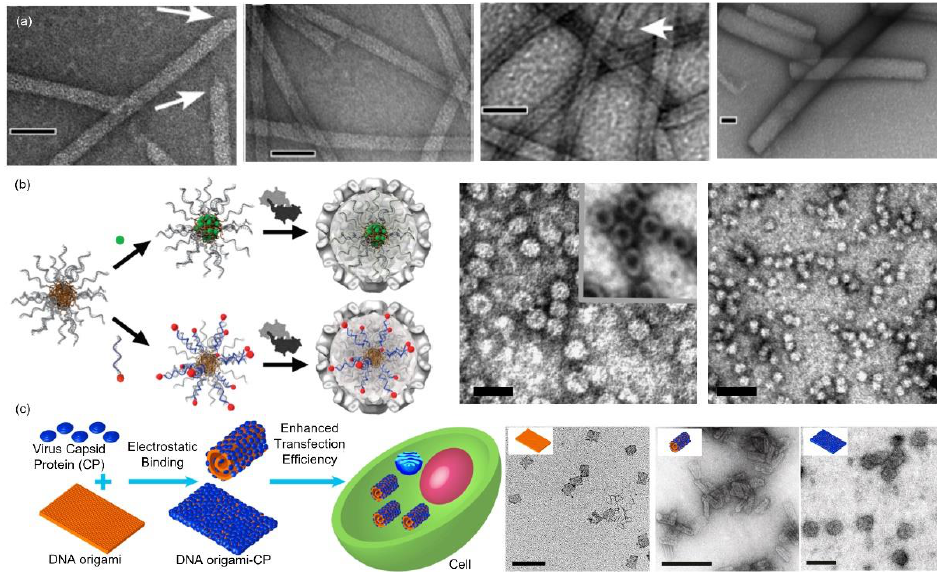
Figure 3. CCMV VLPs templated by DNA nanostructures. ( a ) Representative TEM images of CCMV capsids templated by a 500 bp dsDNA with bp:CP dimer ratios of (from left to right): 1:1, 7:1, 14:1 and 28:1. White arrows mark the hemispherical caps. Scale bar: 50 nm. Reprinted with permission from [48]. Copyright (2006) American Chemical Society. ( b ) Left panel: Schematic illustration of CCMV capsid assemblies templated by DNA micelles and the proposed approaches for drug loading. Right panel: Representative TEM images of (left) assembled CCMV VLPs and (right) free DNA micelles. Scale bar: 40 nm. Reprinted with permission from [50]. Copyright (2010) American Chemical Society. ( c ) Left panel: Schematic illustration of CCMV CP coated DNA origami and the subsequent cellular delivery. Right panel: TEM images and the corresponding illustrative models (insets) of (left) the original rectangular DNA origami, (middle) the rolled tubes of CCMV CP coated DNA origami and (right) unwrapped CCMV CP coated DNA origami. Scale bar: 200 nm. Reprinted with permission from [53]. Copyright (2014) American Chemical Society.